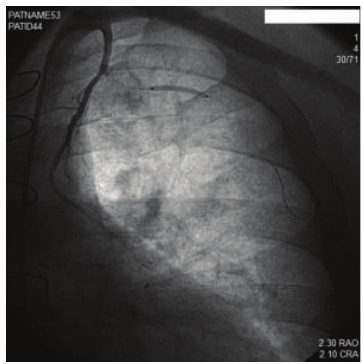
Figure 3: The LIMA was engaged with a 6-French IMA guide catheter. The Doppler wire was then advanced into the mid-portion of the LIMA distal to the first thoracic branch collateral with balloon occlusion of side